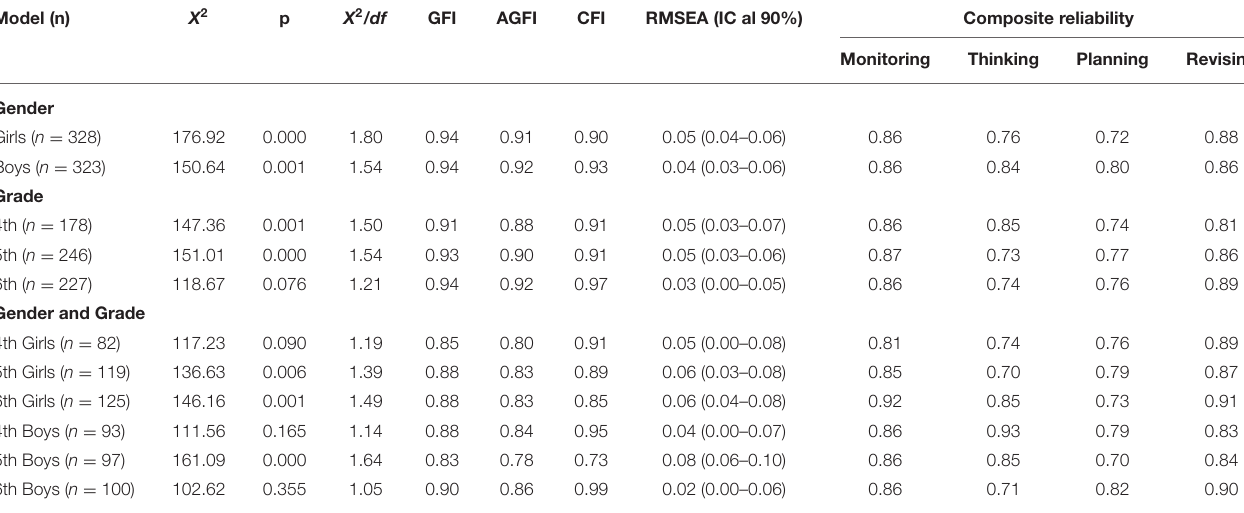
TABLE 3 | Goodness-of-Fit Indices for the proposed model of the questionnaire based on sample features. Model (n) X 2 p X 2 / df GFI AGFI CFI RMSEA (IC al 90%) Composite reliability